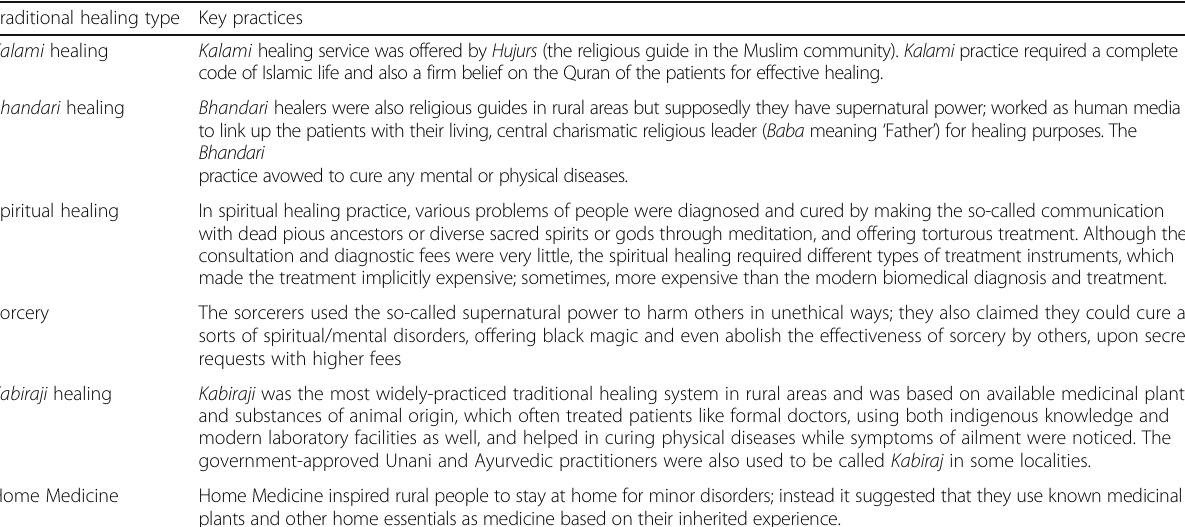
Table 4 Key forms and practices of traditional healers and sorcerers Traditional healing type Key